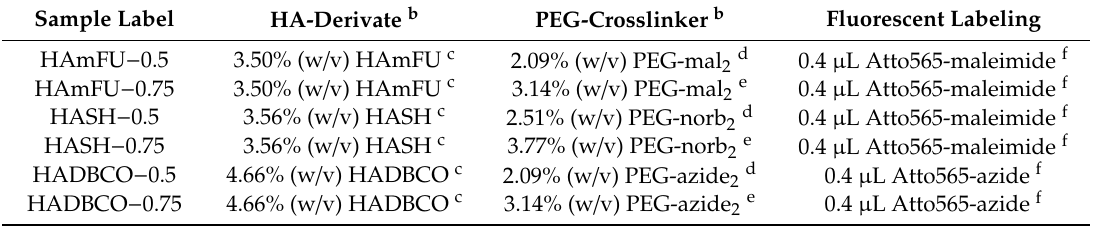
Table 2. Summary of employed precursor solutions for HA-microgel fabrication a